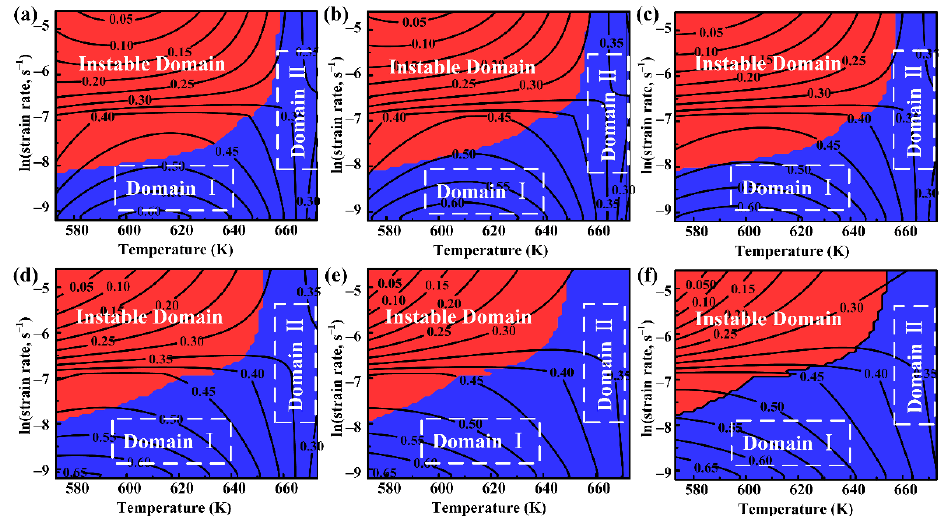
Figure 9. The processing maps of as-extruded Mg–6Zn–5Ca–3Ce fabricated by RS at various strains: ( a ) 0.1; ( b ) 0.2; ( c ) 0.3; ( d ) 0.4; ( e ) 0.5; ( f ) 0.6.